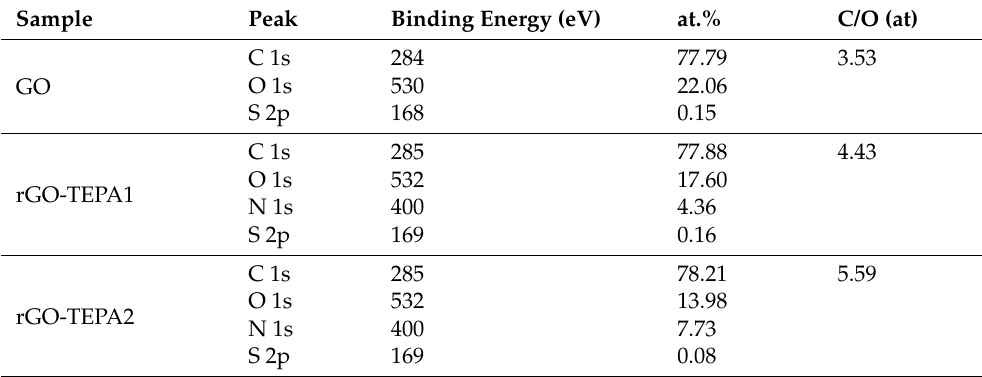
Table 1. Surface elemental compositions of the pristine GO and rGO samples obtained by the XPS